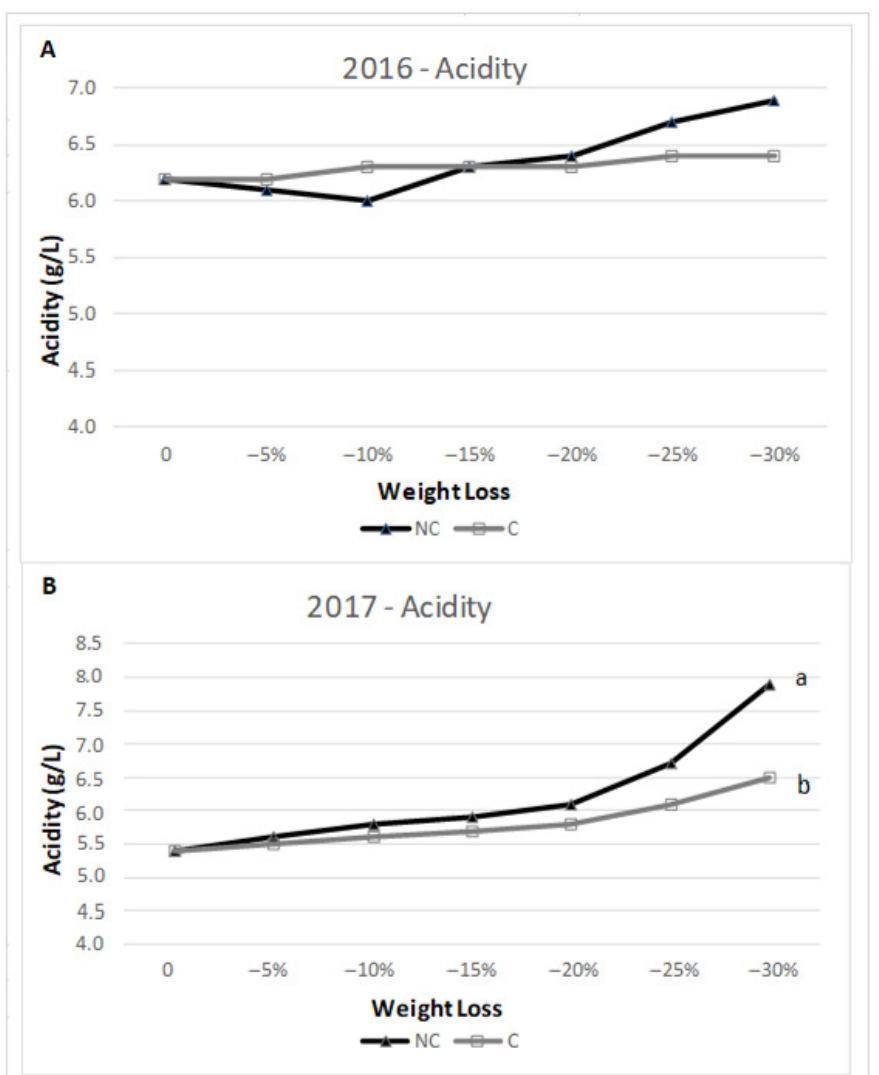
Figure 5. Total acidity (g/L of tartaric acid) in 2016 ( A ) and 2017 ( B ) at harvest date and different WL stages. Where present, values indicated with different letters were significantly different ( p < 0.05) between 3 analytical replicates.